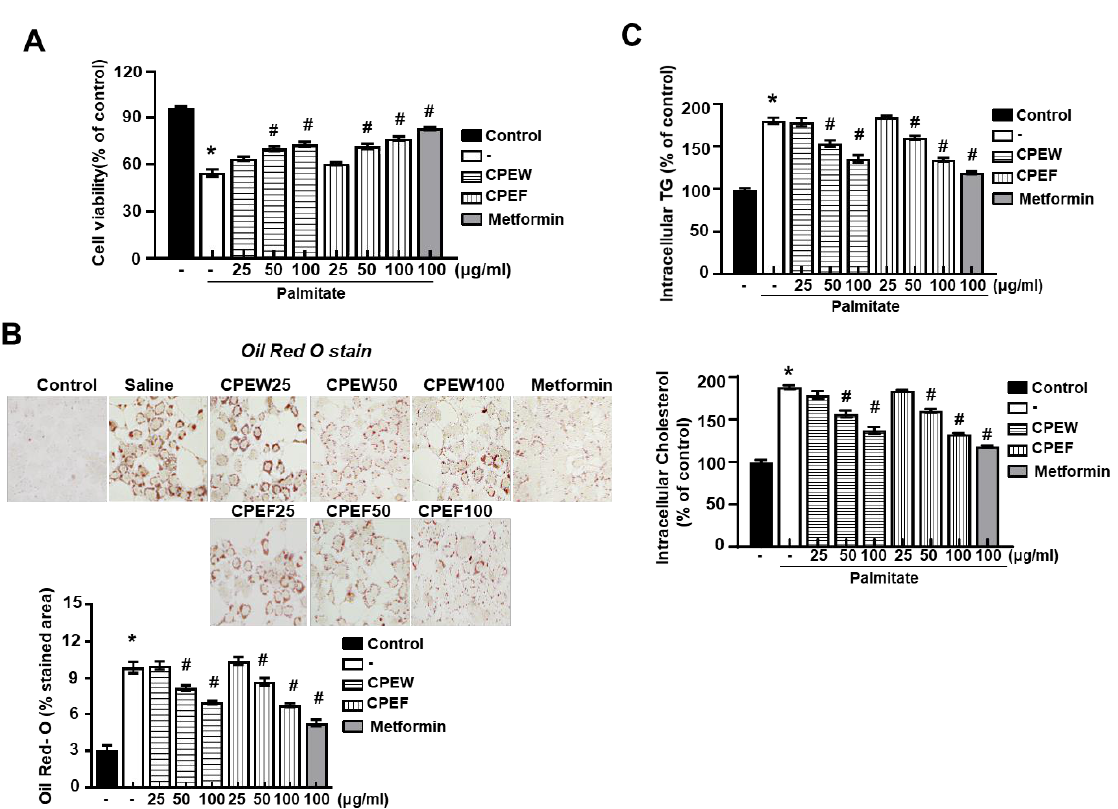
Figure 7. Citrus peel extract regulates hepatic lipid accumulation in palmitate-models. AML12 cells were treated with the indicated concentrations of 50 µ g / mL, 100 µ g / mL, and 200 µ g / mL citrus peel, metformin for 24h for indicated periods, and ( A ) cytotoxicity was determined using the MTT assay. ( B ) Oil-Red-O stain for lipid content staining was measured in the indicated agent treated cells. ( C ) Triglyceride and total cholesterol levels were measured the indicated agent treated cells. Results are mean ± SEM from 3 separate experiments. ( * P < 0.05 vs. control, # P < 0.05 vs. palmitate). CPEW, citrus peel extract hot-air dry; CPEF, citrus peel extract freeze-drying.